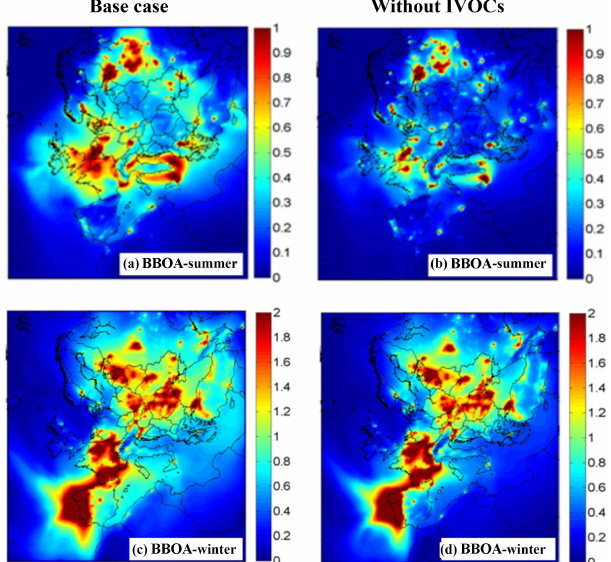
Figure 8. Predicted ground-level concentrations of PM 2 . 5 total BBOA (µgm − 3 ) during the modeled summer period (a–b) and the modeled winter (c–d) period. The figures to the left are for the PMCAMx-SR base case simulation while those to the right are for the low-IVOC sensitivity test.